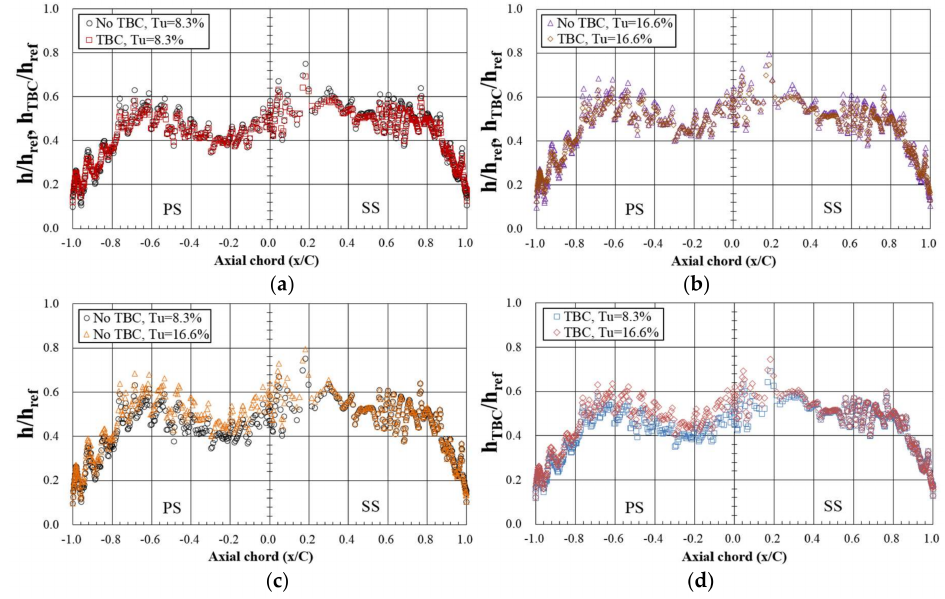
Figure 12. h and h TBC distributions at midspan at Tu = 8.3% and 16.6% in comparisons between ( a ) h and h TBC at Tu = 8.3%, ( b ) h and h TBC at Tu = 16.6%, ( c ) h at Tu = 8.3% and 16.6%, and ( d ) h TBC at Tu = 8.3% and